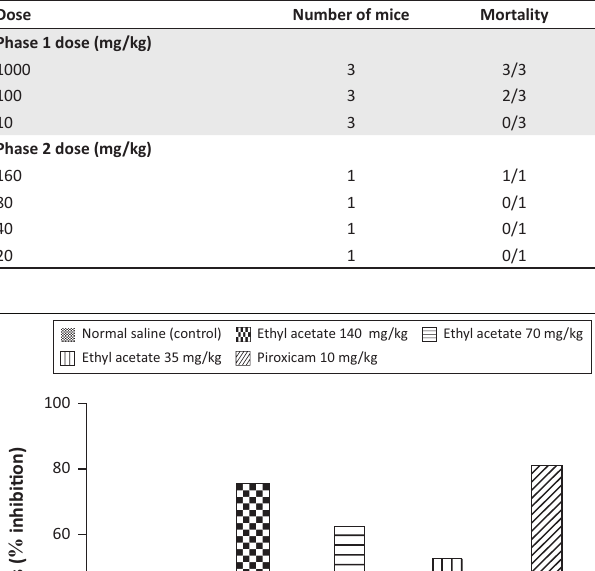
TABLE 3: Acute toxicity of methanol